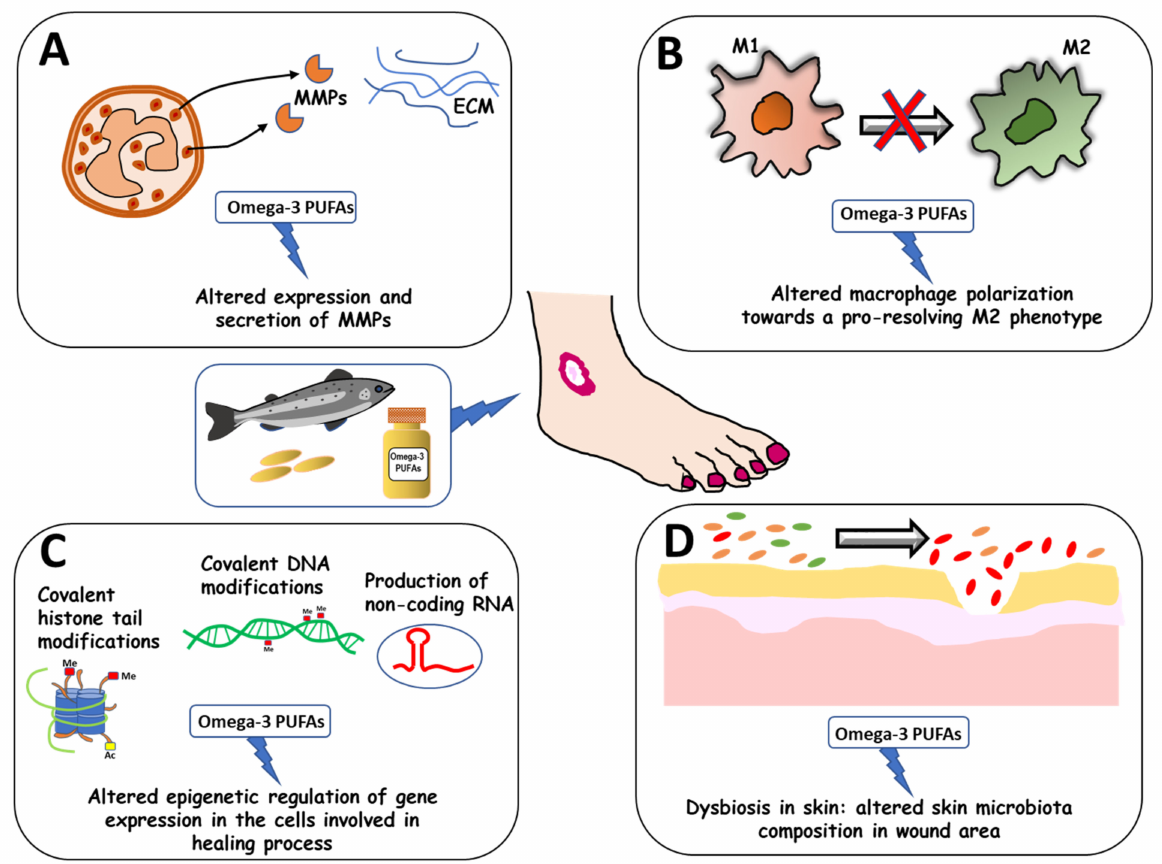
Figure 1. Future perspectives in research on nonhealing ulcers and Omega-3 PUFAs. Possible roles of Omega-3 PUFAs in the following altered processes that hamper and delay healing in diabetes or chronic venous leg ulcers: ( A ) altered expression/secretion of MMPs by innate immune cells; ( B ), altered polarization of macrophages; ( C ), altered epigenetic modulation of gene expression; ( D ), altered microbiota skin